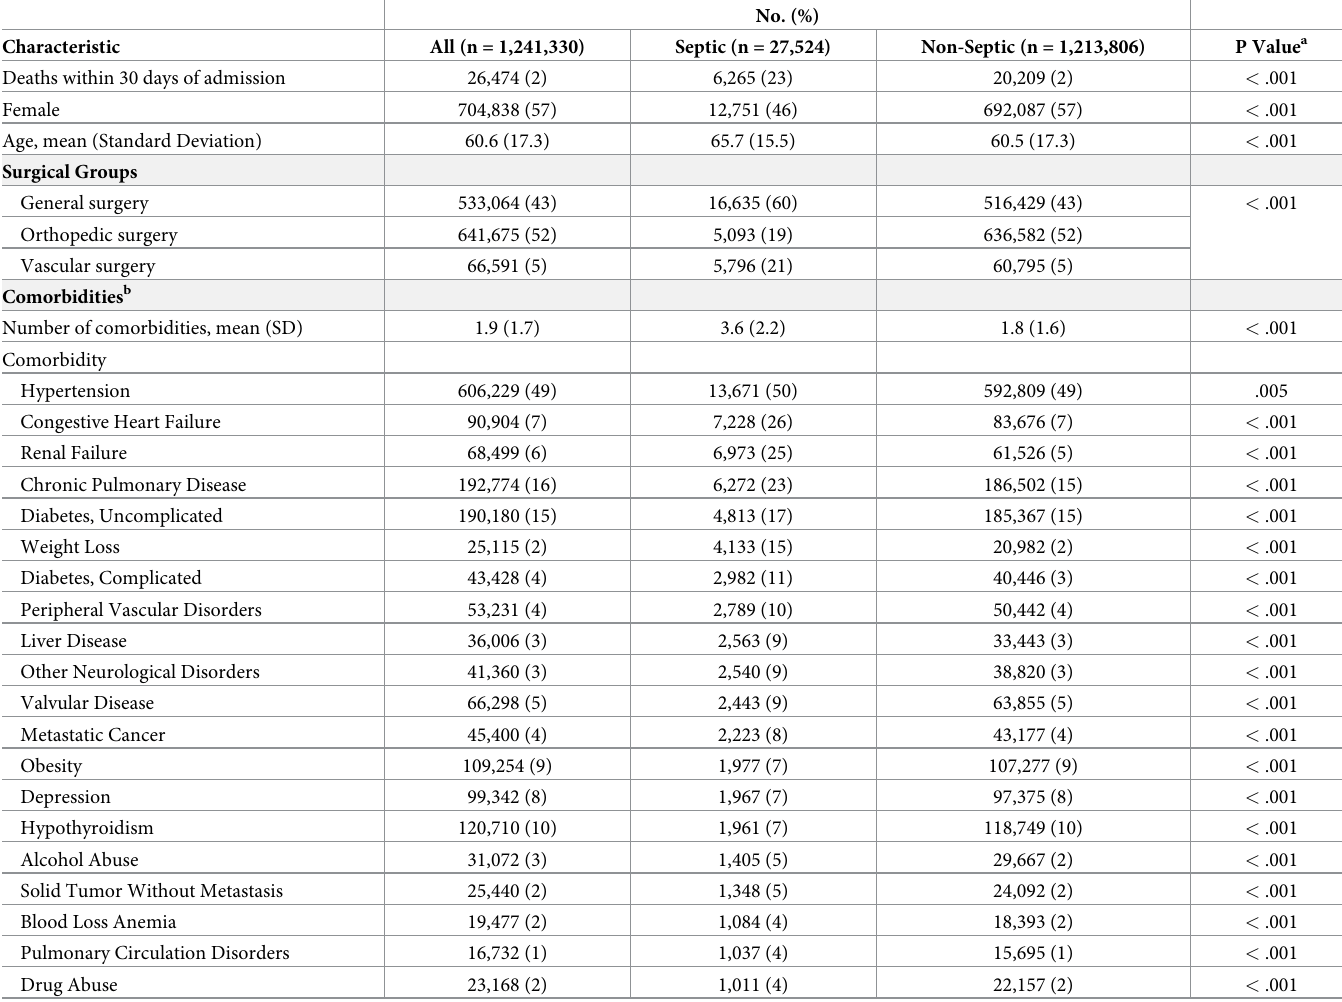
Table 3. Characteristics of surgical and surgical sepsis patients.